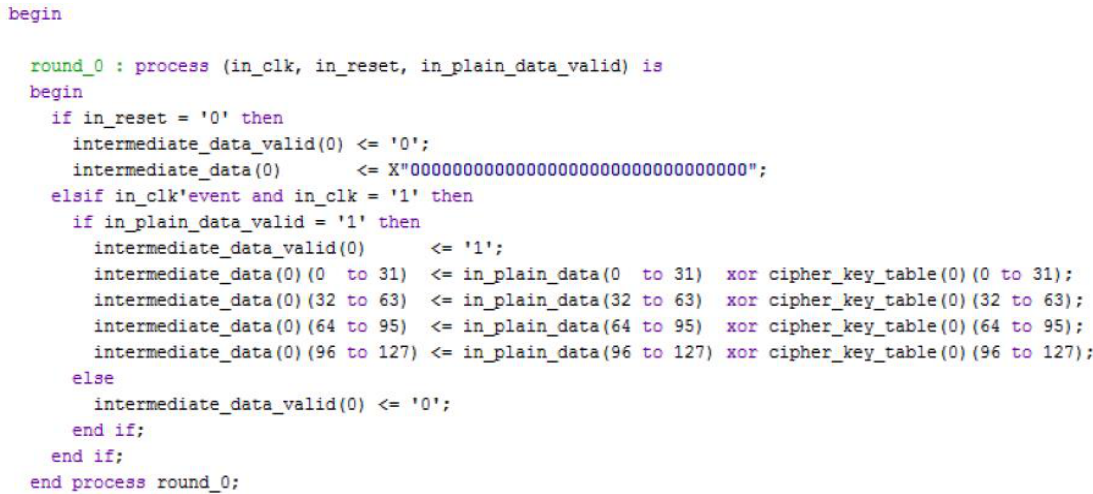
Figure 12. Code Section related to the first round (called round_0) of the AES-128 algorithm.